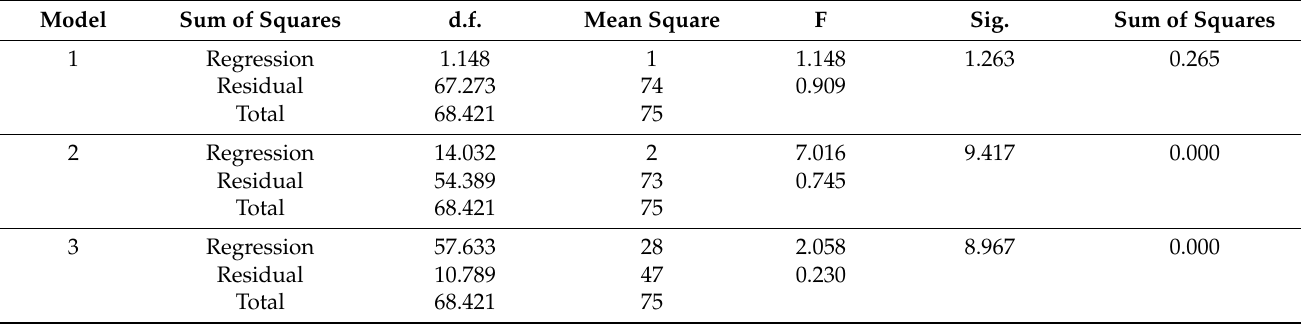
Table 4. ANOVA results.